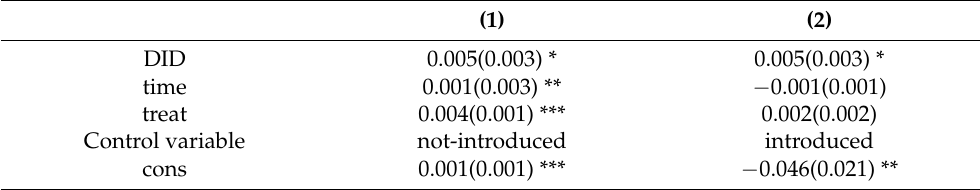
Table 3. The impact of supplementary reform of collective forest son farmers’ investment.